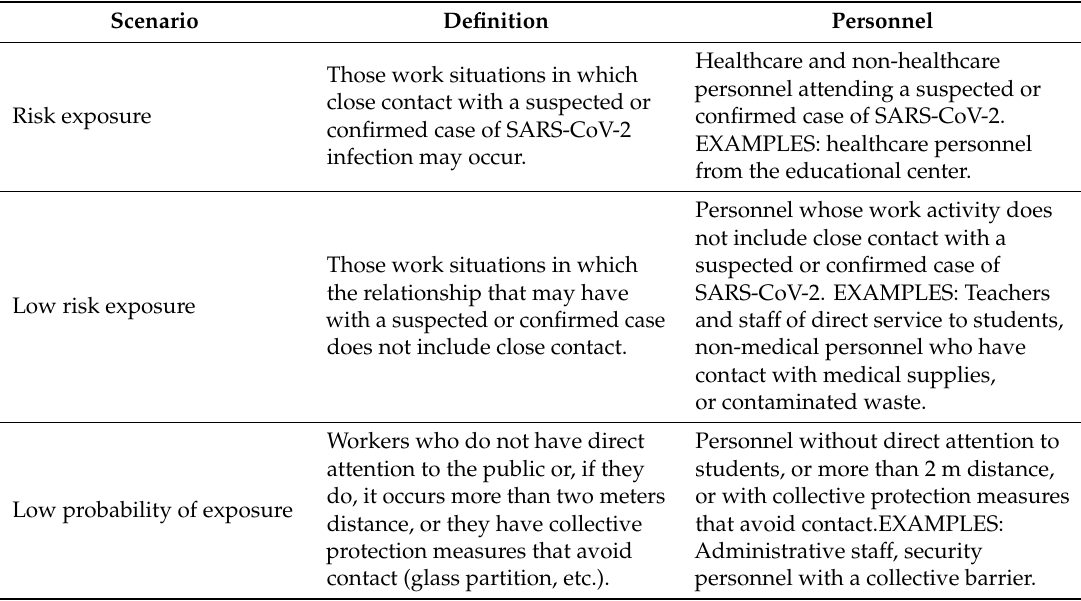
Table 1. Exposure scenarios to